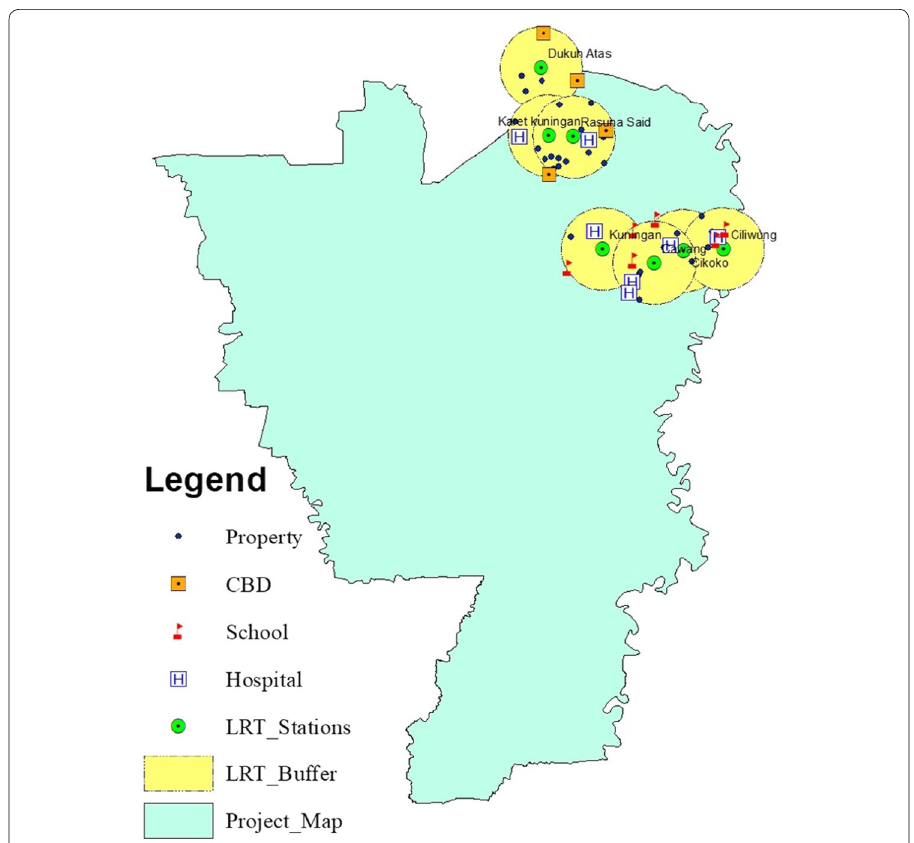
Fig. 4 Map of property listings in South Jakarta located within 1 km radius from transit